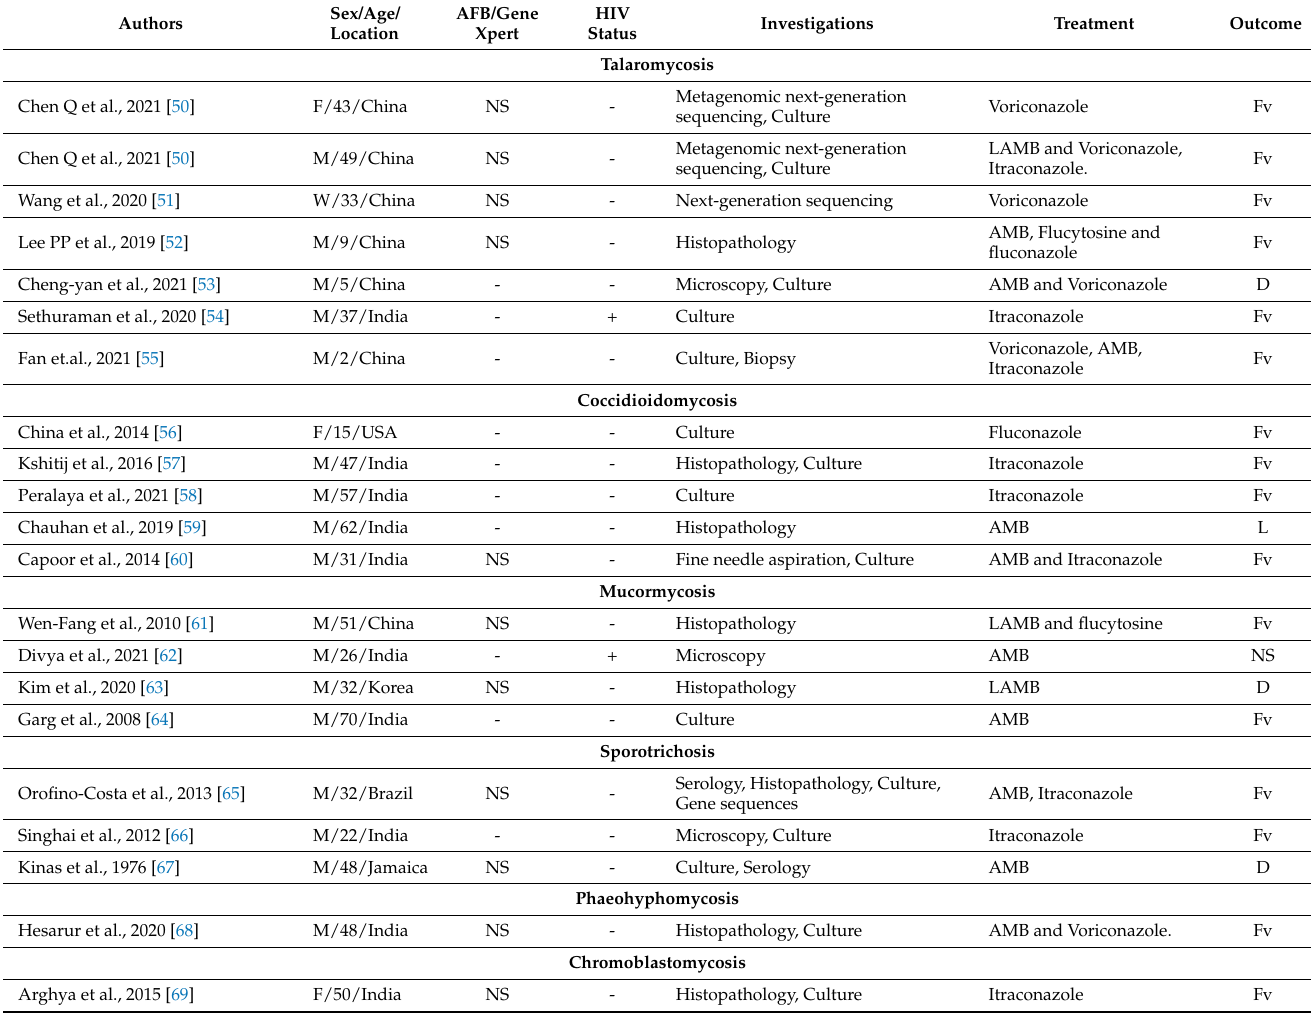
Table 6. Cases of talaromycosis, coccidioidomycosis, mucormycosis, sporotrichosis, chromoblasto- mycosis and phaeohyphomycosis misdiagnosed as